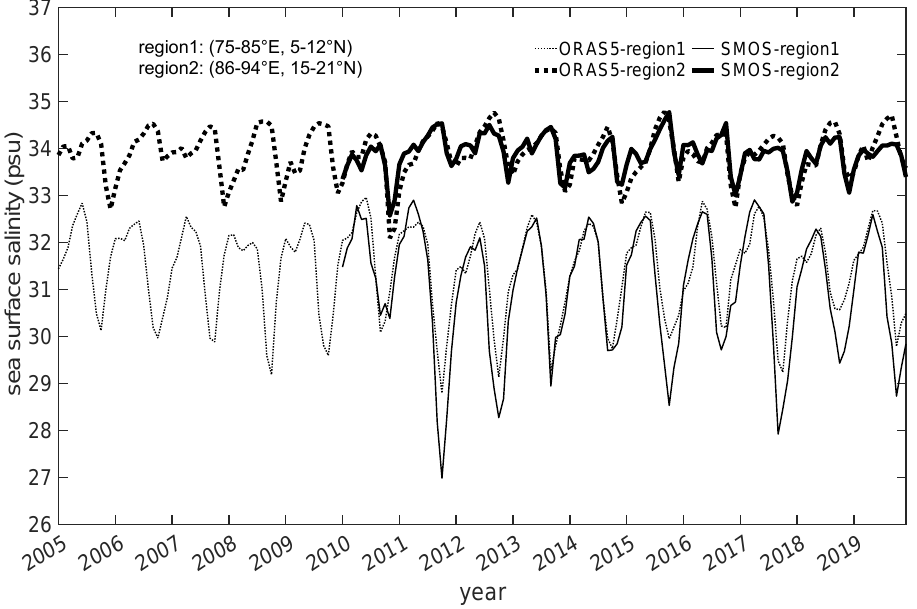
Figure 4. Comparison of the time series of ORAS5 and SMOS sea surface salinity for region 1 (thin line) and region 2 (thick line) from 2005 to 2019. Dash lines represent the sea surface salinity from the ORAS5 dataset; solid lines represent the sea surface salinity from the SMOS dataset.